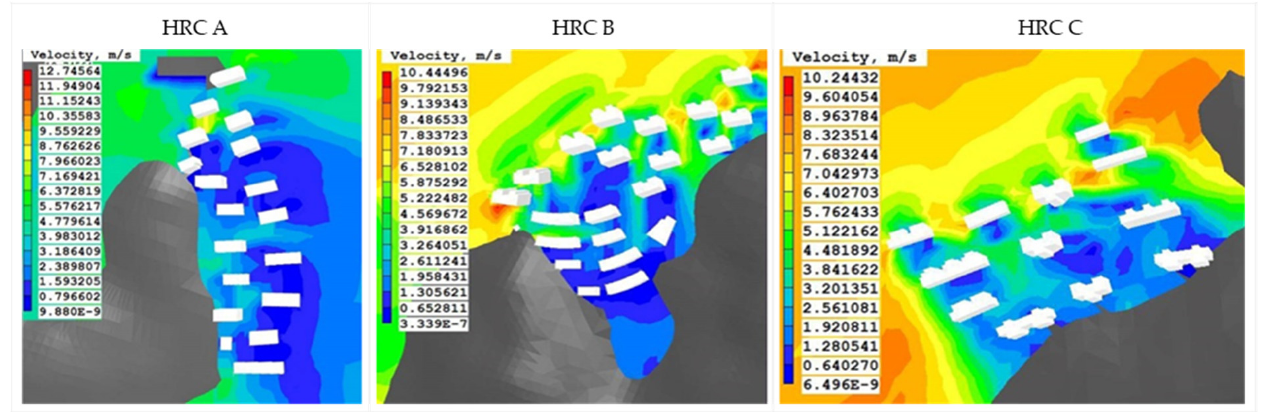
Figure 18. The simulated wind conditions in HRC A ( left ), B ( middle ), and C ( right ) after optimiza- tion.